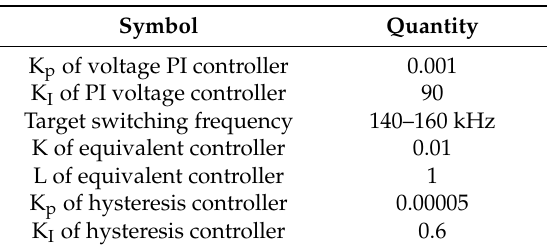
Table 2. Controller parameters of modified ´Cuk